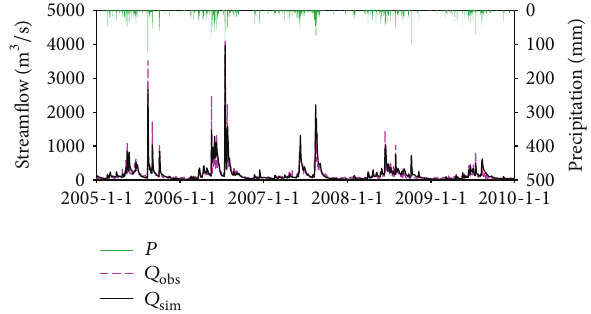
Figure 7: Streamflow simulations at Shilong station, where 𝑃 is is simulated is observed streamflow, and 𝑄 precipitation, 𝑄 sim obs streamflow by BTOPMC.